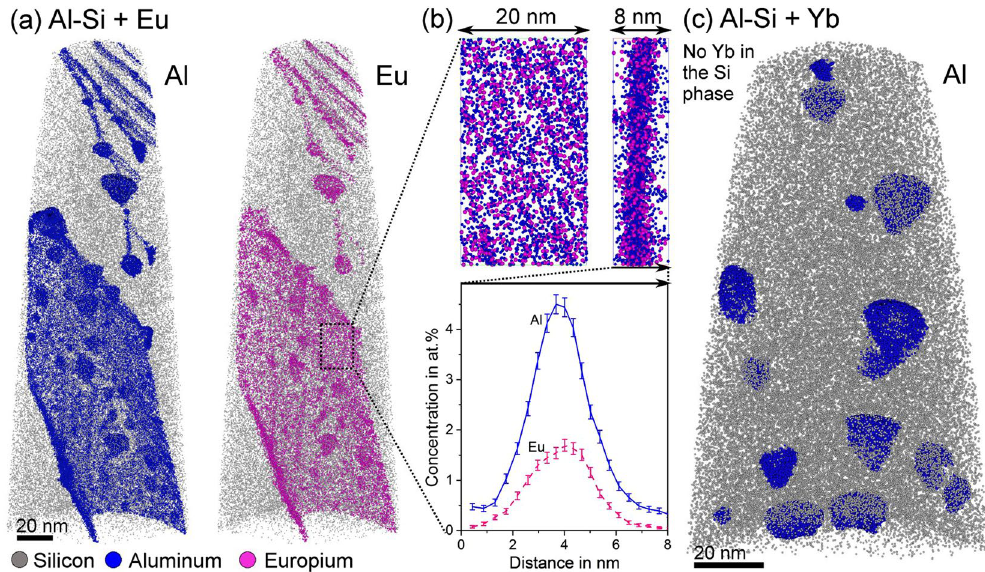
Figure 3. APT comparison of the solute distribution in Si. ( a ) Alloy modified by Eu presenting rod-like, planar and round clusters, all of them containing Al and Eu; ( b ) inset of the planar atomic clustering with a one- dimensional concentration profile across the segregation plane. ( c ) Alloy with Yb addition presenting only Al rounded clusters in Si. No Yb peaks were detected in the mass spectrum of the Si phase.